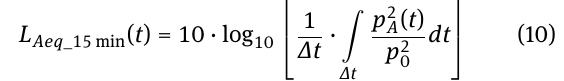
CAL21), a software tool for sound post-processing (01dB dBTrait) and a digital audio